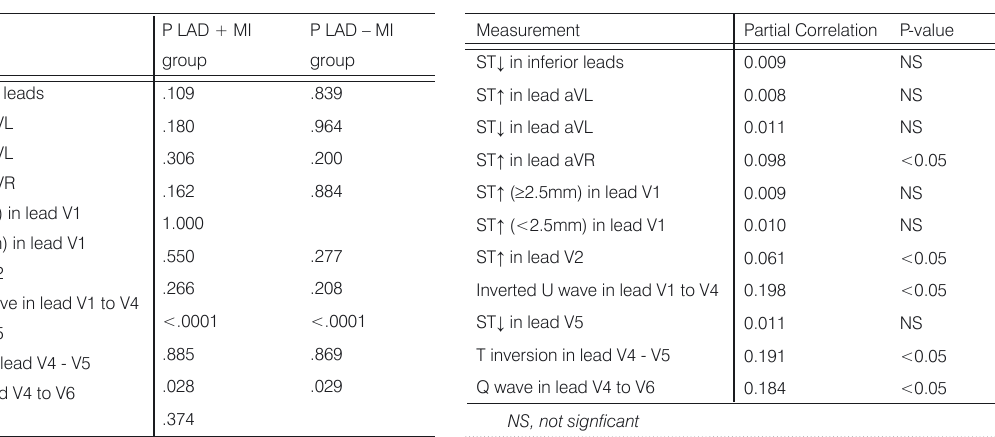
Table 4. P-values of each ECG parameter in P LAD+ MI group & P LAD – MI group.